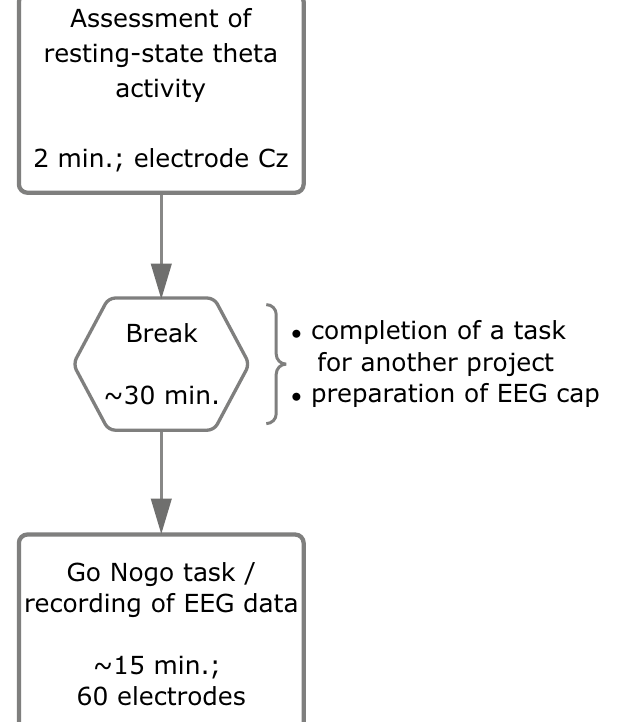
Figure 1. Flowchart showing the individual steps of the data collection and their